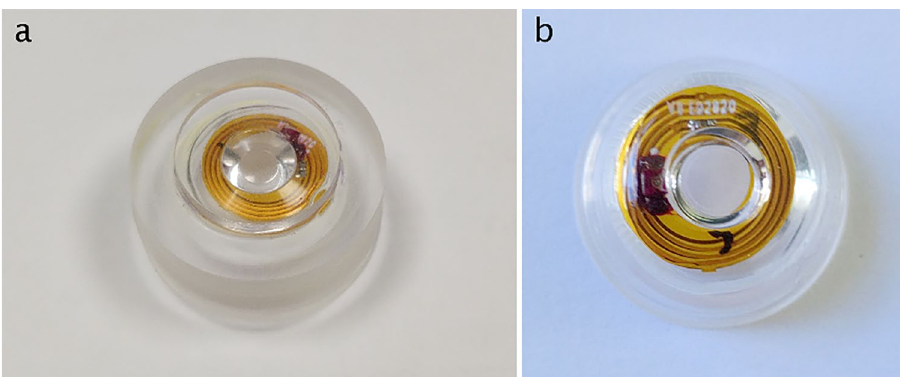
Figure 11. ( a ) View of the SCL pucks before lathing, and ( b ) of the final lathed